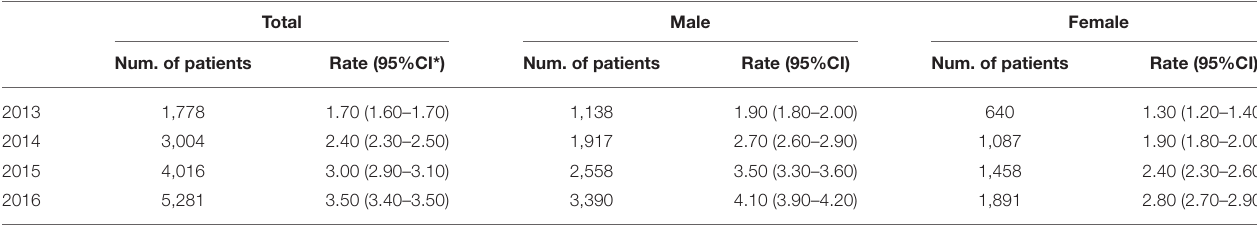
TABLE 3 | Annual crude prevalence rate of Crohn’s disease among urban employees in 23 provinces (municipalities, autonomous regions) of China from 2013 to 2016 (per 100,000 persons). Total Male Female Num. of patients Rate (95%CI*) Num. of patients Rate (95%CI) Num. of patients